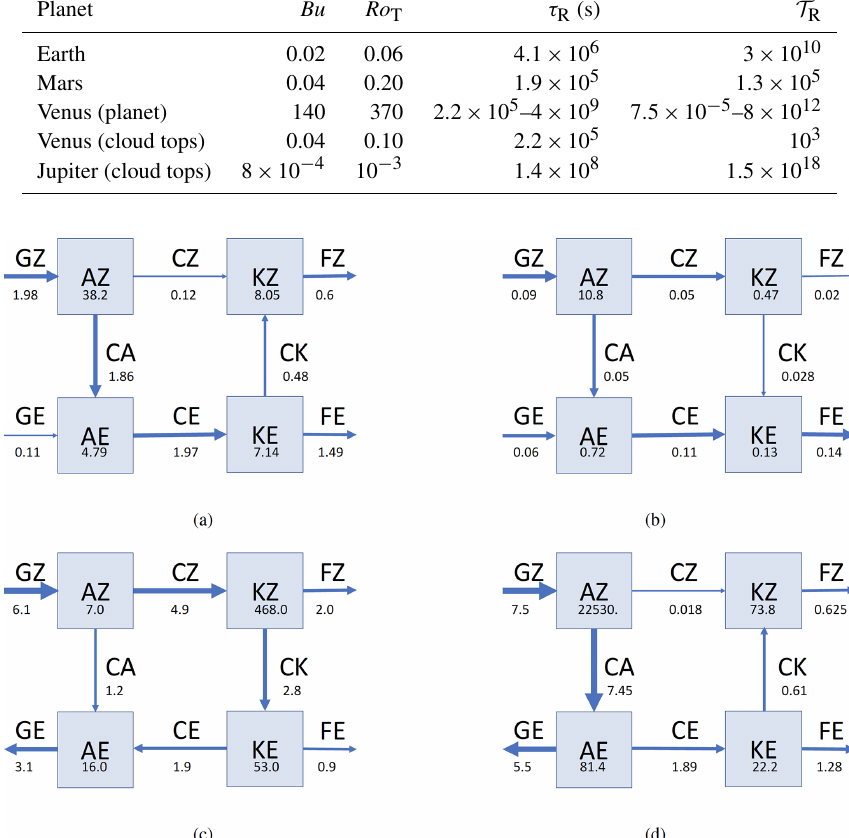
Table 2. Estimates of the main dimensionless parameters for Earth, Mars, Venus and Jupiter. Estimates of the radiative time constant are based on values from NASA’s Planetary Data System (PDS; see https://pds-atmospheres.nmsu.edu/education_and_outreach/encyclopedia/ radiative_time_constant.htm, last access: 30 March 2020).